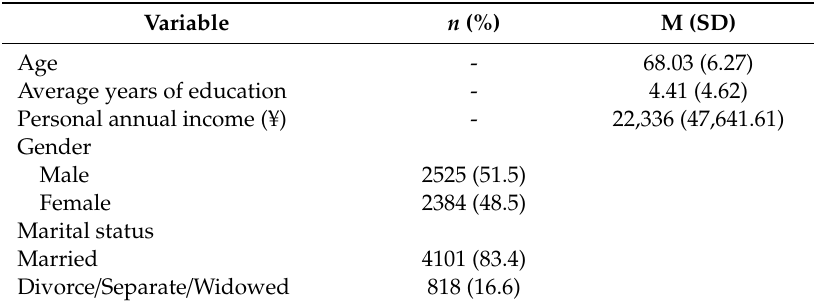
Table 1. Characteristics of the study sample ( n =